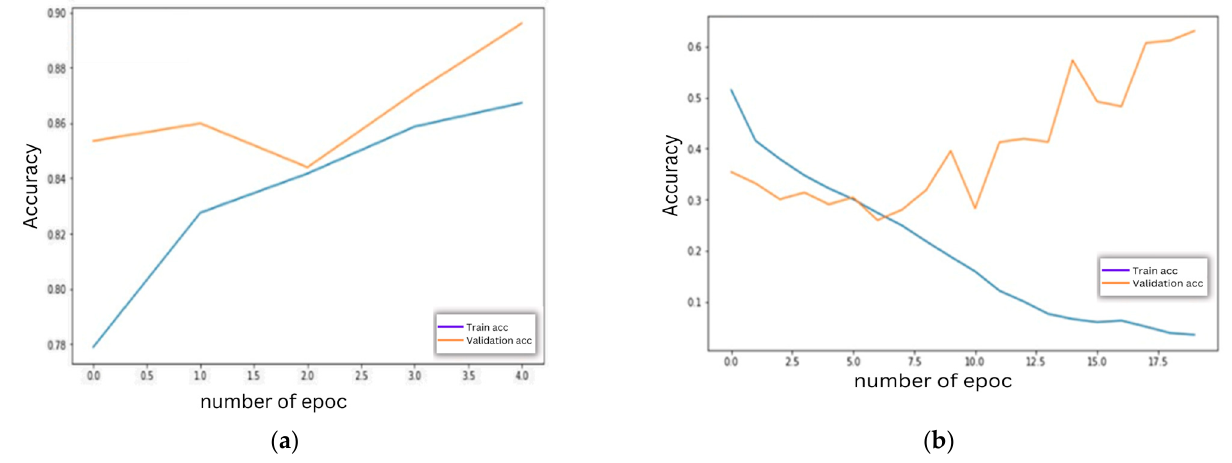
Figure 7. ( a , b ) depict the relationship between loss and the number of epochs.